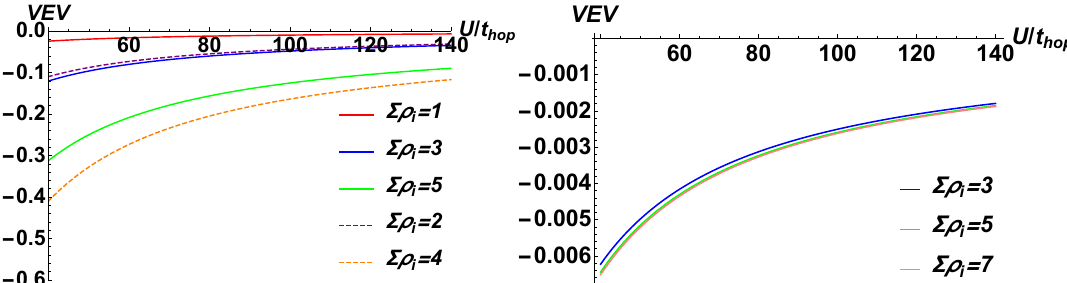
Figure 5 . The VEV in the non-homogeneous phase at the (cid:12)nite coupling q = p 6 = 5 and and the Neumann IR boundary condition (2.16). For any (cid:26) ( i ) satisfying normalized VEV is plotted as the function of U=t hop when u h = 40, (cid:21) = w = (cid:3) = 1, and (cid:3) ( p;q ) = 0. The absolute value of the VEV in the non-homogeneous phase (red and blue curve) is smaller than the one of the homogeneous phase (purple and green curve). V EV b =V EV IR as a function of U=t hop for curves with the same parameters (colors). V EV b =V EV IR is zero when M 2 = 0 ; P (cid:26) i = even. The ratio becomes large and with the opposite sign compared to the homogeneous phase.